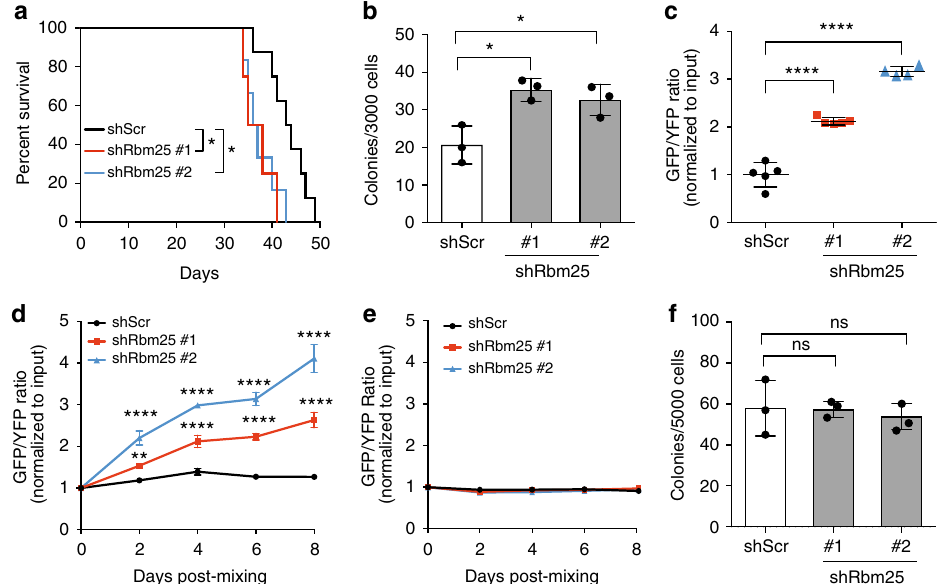
Fig. 2 Functional validation of Rbm25 in murine AML. a Kaplan − Meier survival analysis of mice injected with AML cells transduced with the indicated shRNAs ( n = 8, log-rank test, * P < 0.05). b Colony-forming assay performed on Lp30 cells transduced with shScr or shRbm25. 3000 GFP + cells were sorted and plated in MethoCult M3434 medium 2 days after transduction (data represent the mean ± s.d., n = 3). c The effects of shRbm25 on tumor growth in a serial in vivo competitive BM transplantation assay (data represent the mean ± s.d., n = 4). d , e Competitive assays performed on d MLL-AF9 and e c-Kit + BM cells transduced with shScr or two individual shRNA targeting Rbm25 . Graph shows the GFP/YFP ratio over time normalized to input mixture. f Colony-forming potential of normal c-Kit + BM cells transduced with shScr or shRbm25. Cells were plated in M3434 semi-solid medium 2 days after transduction (data represent the mean ± s.d., n = 3). Data were subjected to an unpaired t test, and asterisks indicate the following: * P < 0.05; ** P